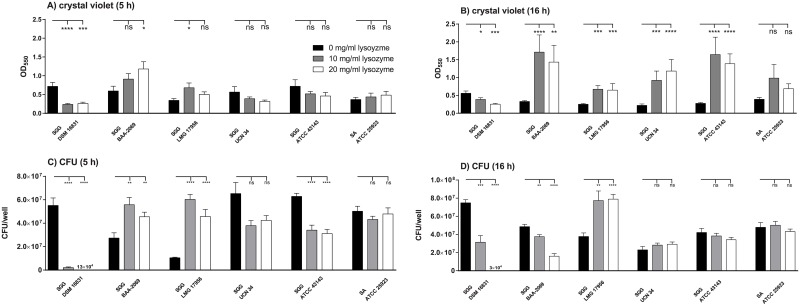
Biofilm formation after 5 and 16 h lysozyme treatment compared to the control.Biofilm formation on polystyrene was detected with crystal violet staining and absorption was determined photometrically (A+B) or by plaiting assay (C+D) after 5 and 16 h. The biofilm formation in BHI without lysozyme is compared to medium supplemented with lysozyme. Statistical significance between the different time points of a strain is marked with stars (Mann-Whitney U test, *: p < 0.05; **: p < 0.005; ****: p < 0.0001; n = 4). The standard deviation is marked with error bars. SGG = Streptococcus gallolyticus subsp. gallolyticus; SA = Staphylococcus aureus.